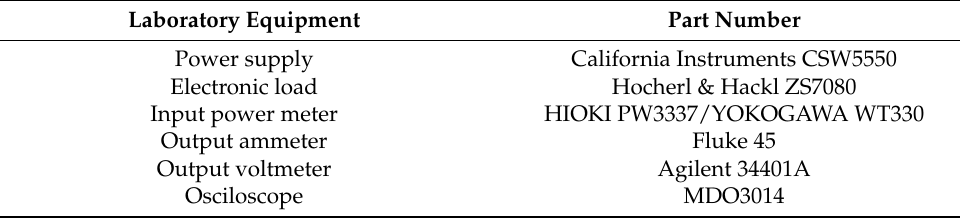
Table 2. Main input-to-output operational parameters of non-optimized three-phase PFC circuit and circuit components specification.